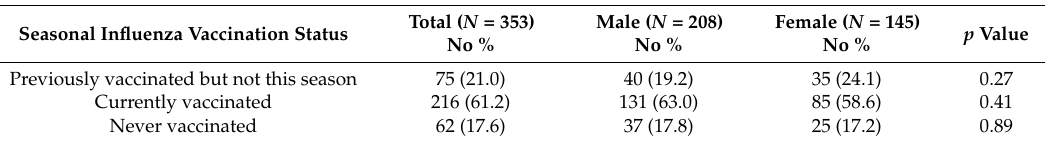
Table 1. Influenza vaccination status in vaccination season 2017–2018 among study type 2 diabetes mellitus (T2DM) patients by gender ( N =